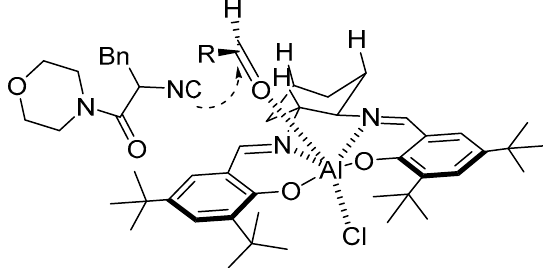
Figure 8. Proposed mechanism in the reaction of isocyanides with aldehydes.